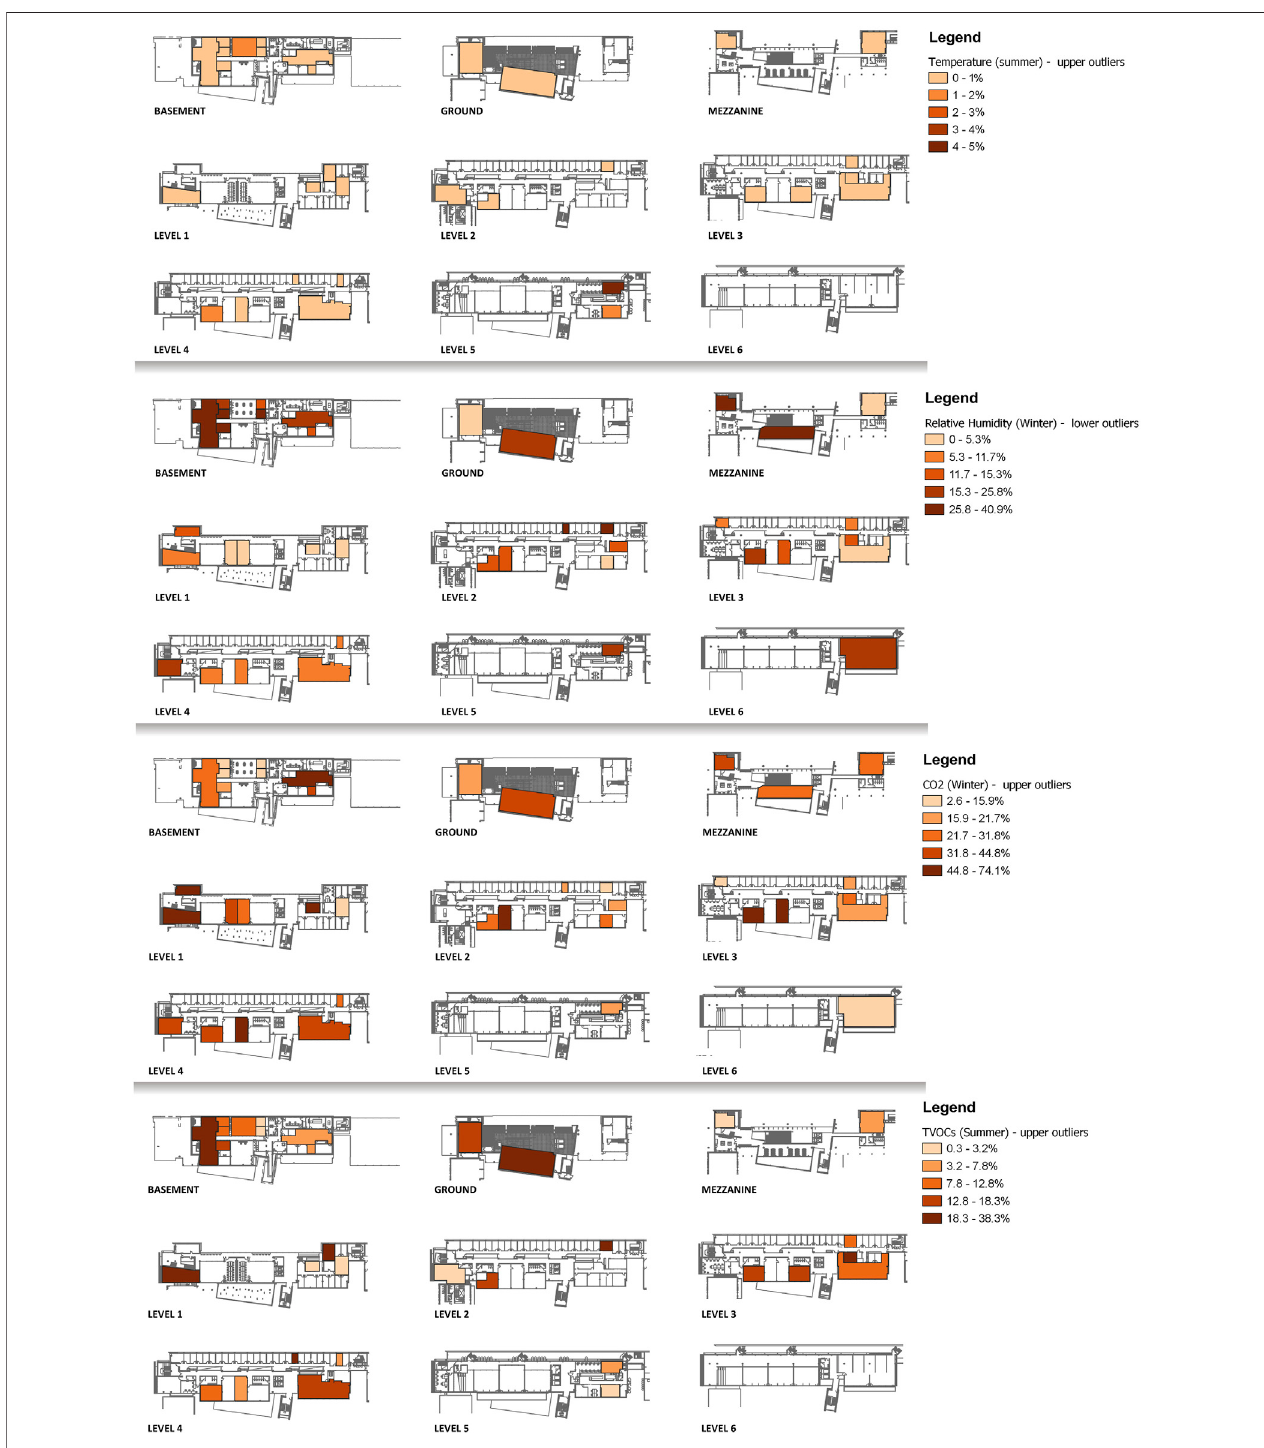
FIGURE 6 | GIS localization and categorization of rooms according to their proclivity to extreme events. From top to bottom: occurrence of summer upper T outliers, winter lower RH outliers, winter upper CO 2 outliers, and summer upper TVOCs outliers (percent time). Upper and lower outliers are those exceeding the 75th percentile or falling below the 25th percentile by 1.5 times the interquartile range.